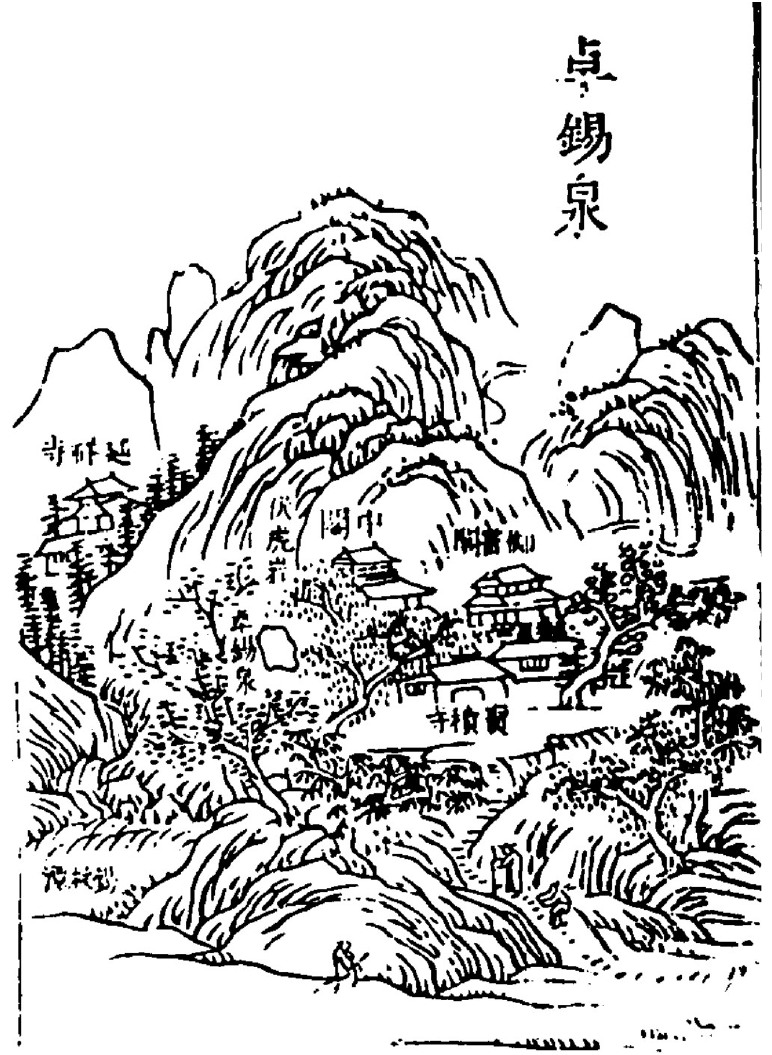
Figure 13. Image of the Zhuoxi Quan, 1639. Woodblock print. After Han Huang, Luofu yesheng , 2.35a (517).